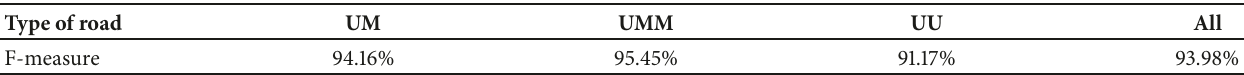
Table 5: F-measure score for urban marked road, urban multiple marked lane, and urban unmarked road respectively of the KITTI test benchmark.